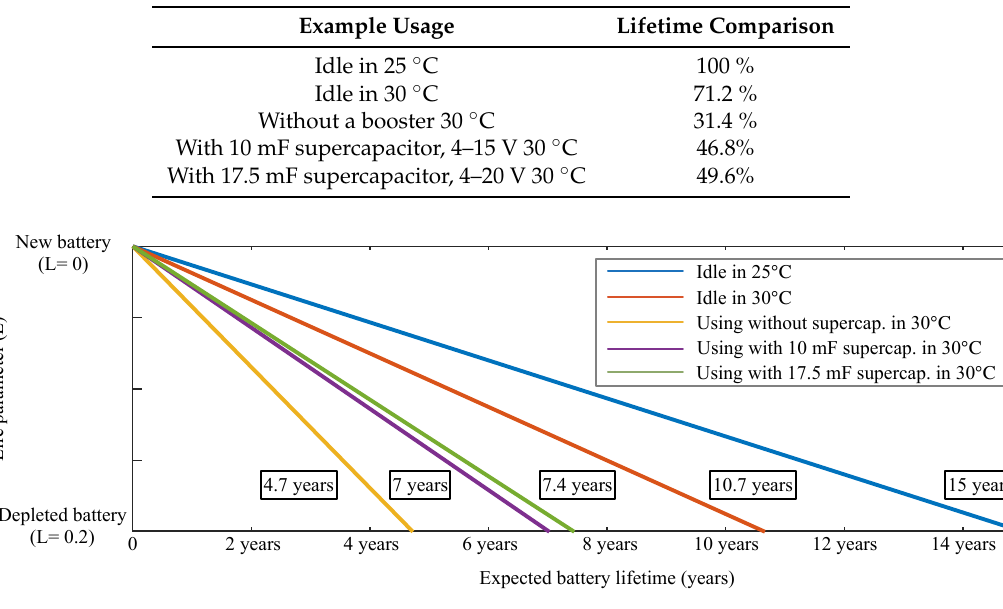
Figure 10. Comparison of the estimated life parameter.